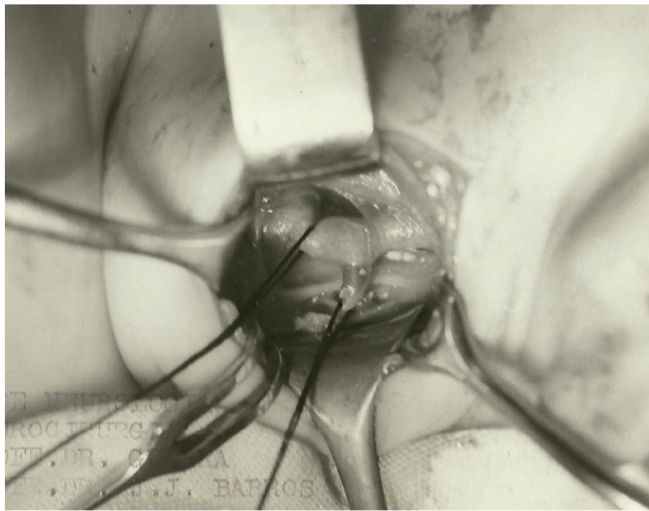
Figure 3 - Dissection of the internal jugular and facial veins for passage of the catheter.